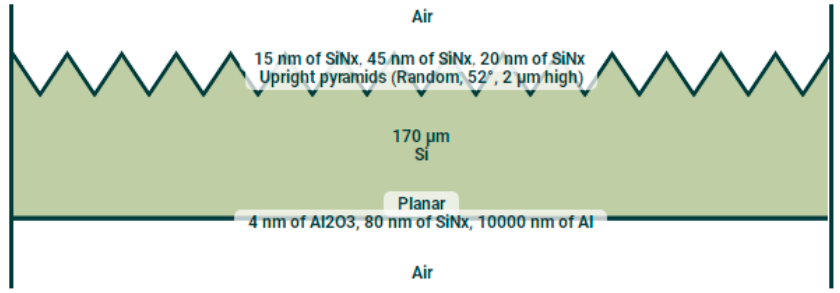
Figure 2. The simulation structure of monocrystalline silicon PERC solar cells in SunSolve. The front busbars and fingers are excluded to focus on the antireflection coating.